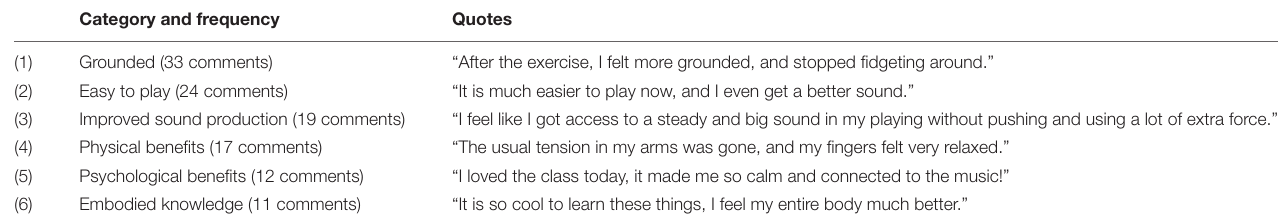
TABLE 2 | Qualitative feedback